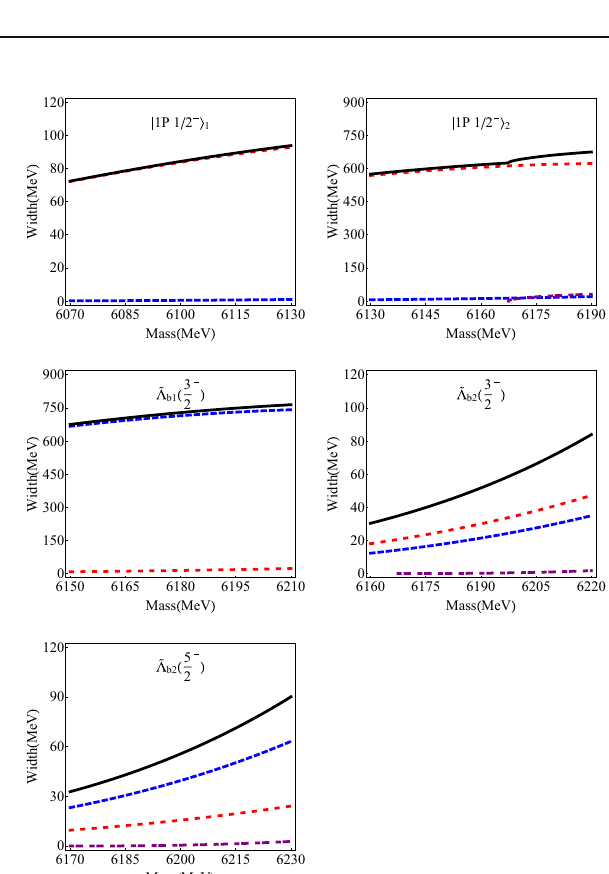
Fig. 4 The decay behaviors for the ˜ (cid:2) b ( 1 P ) states versus their initial masses. The black lines correspond to the total decay widths. The red dotted, blue dashed, purple dot-dashed lines stand for the partial decay π , and (cid:2) η channels, respectively. The (cid:2) widths of (cid:4) b π , (cid:4) ∗ b b for | 1 P 1 / 2 − (cid:6) 2 state arises due to the allowed phase space and mixing